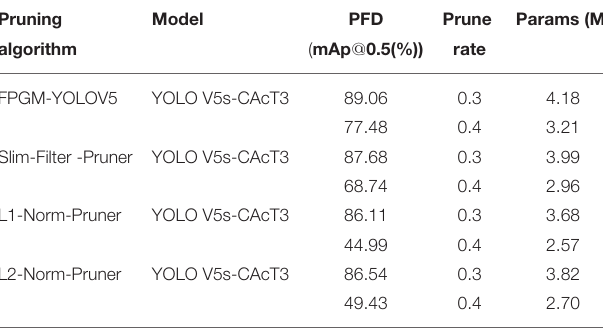
TABLE 8 | Results of different pruning